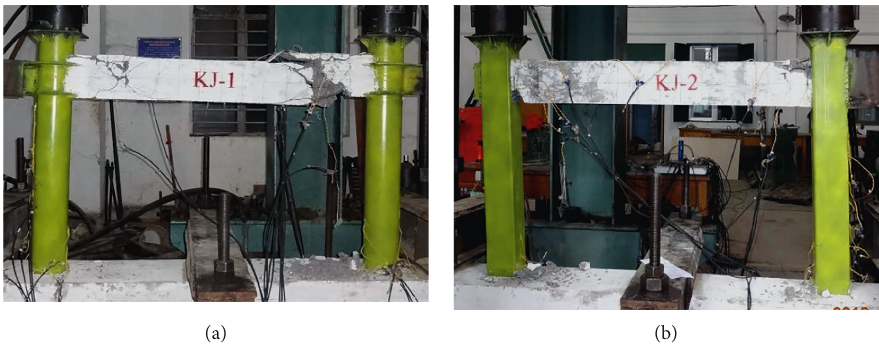
Figure 3: Overall failure mode: (a) specimen KJ-1, (b) specimen KJ-2.